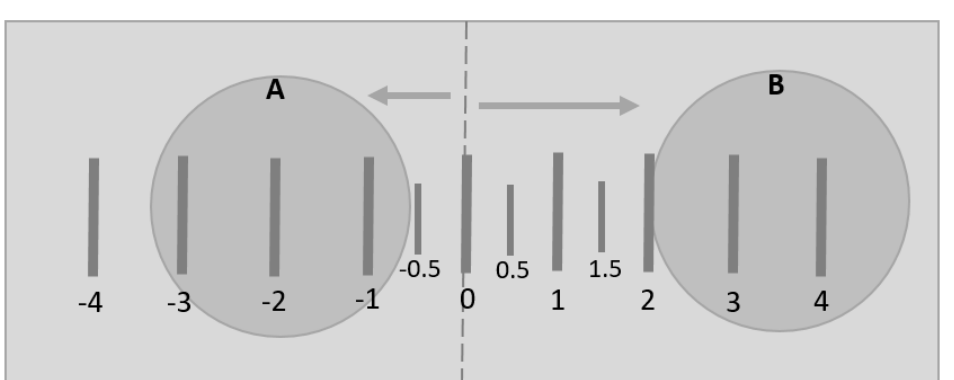
Figure 7. Taking Data. The markings on the plate represent measurements in cm. The circles depict the sensors with the arrow demonstrating the direction of movement. As shown in the figure, if moving right, the left edge is aligned and if moving left the right edge is aligned. The measurement is always counted from the right edge, so in this figure sensor A reads at 0.5 cm while sensor B reads at 5